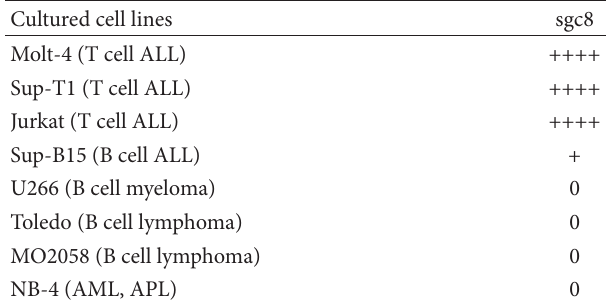
in protein composition can be the result of posttranslational T 1: Speci�city of sgc8 aptamer for T-ALL cancer cells. binding capacity of the aptamer to the cells.